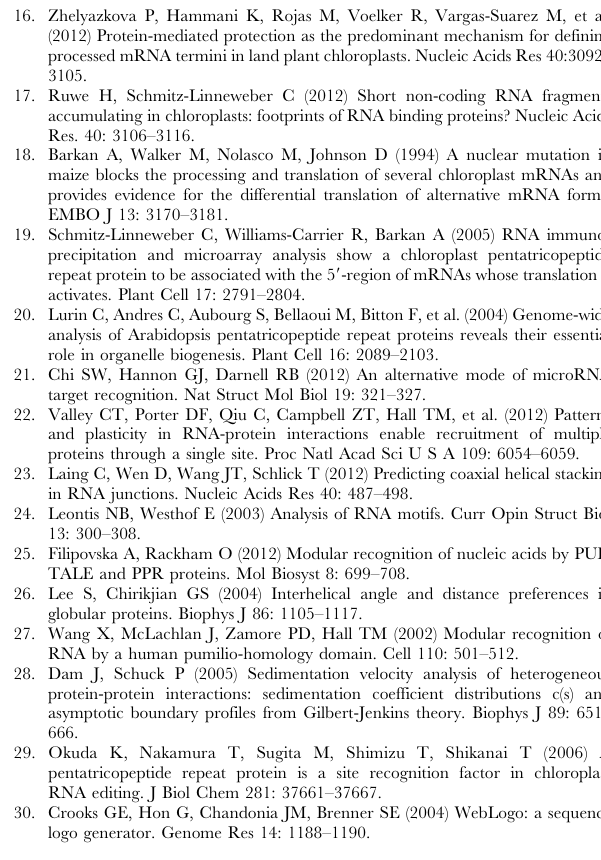
correspond to the alignments depicted in Figure 2. Orientation: forward indicates N- . C, 5 9 -3 9 ; reverse indicates N- . C, 3 9 -5 9 . Offset: distance from start of RNA sequence to first PPR motif. Gap position: nucleotide at which gap introduced between protein motifs. Gap length: length of gap in nucleotides. 17-mer: position (from 1 to 35) within the PPR motifs used to constitute the 17-mer sequence of amino acids used for the alignment. P-value: probability that amino acids and nucleotides are arranged independently of each other, as calculated by Fisher’s Exact Test. None of the 29400 alignments exceed the threshold for significance at the 5% level if a threshold corrected for the total number of tests is used (5% threshold using the Sˇida´k correction=1.74E-06). (PDF) Table S2 Correlations between amino acids at specific positions within PPR motifs and aligned nucleotides. Contingency tables (amino acids versus nucleotides) were constructed from the alignments in Figure 2 and Figure S1. Each 20 6 4 table was tested for independent assortment of amino acids and nucleotides using a chi-squared test (after first removing any empty rows from the table). P-values from the tests are shown in the table, with those values that are significant for both P and S motifs highlighted (a 1% significance threshold was used, corrected for multiple tests using the Sˇida´k correction). Rows: amino acid positions within the motifs. Columns: 0 indicates the motif aligned with the nucleotide, 2 1 the preceding motif, + 1 the following motif. (PDF)